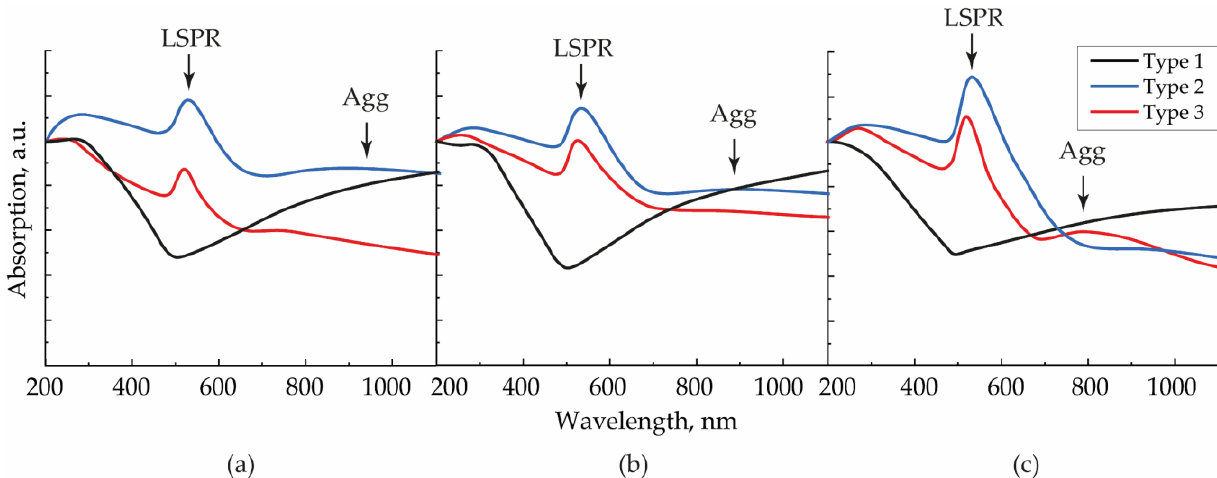
Figure 4. Absorption spectra for SERS structures of types 1 – 3, formed with aerosol flows ( a ) 50, ( b ) 200, and ( c ) 400 mL/min.